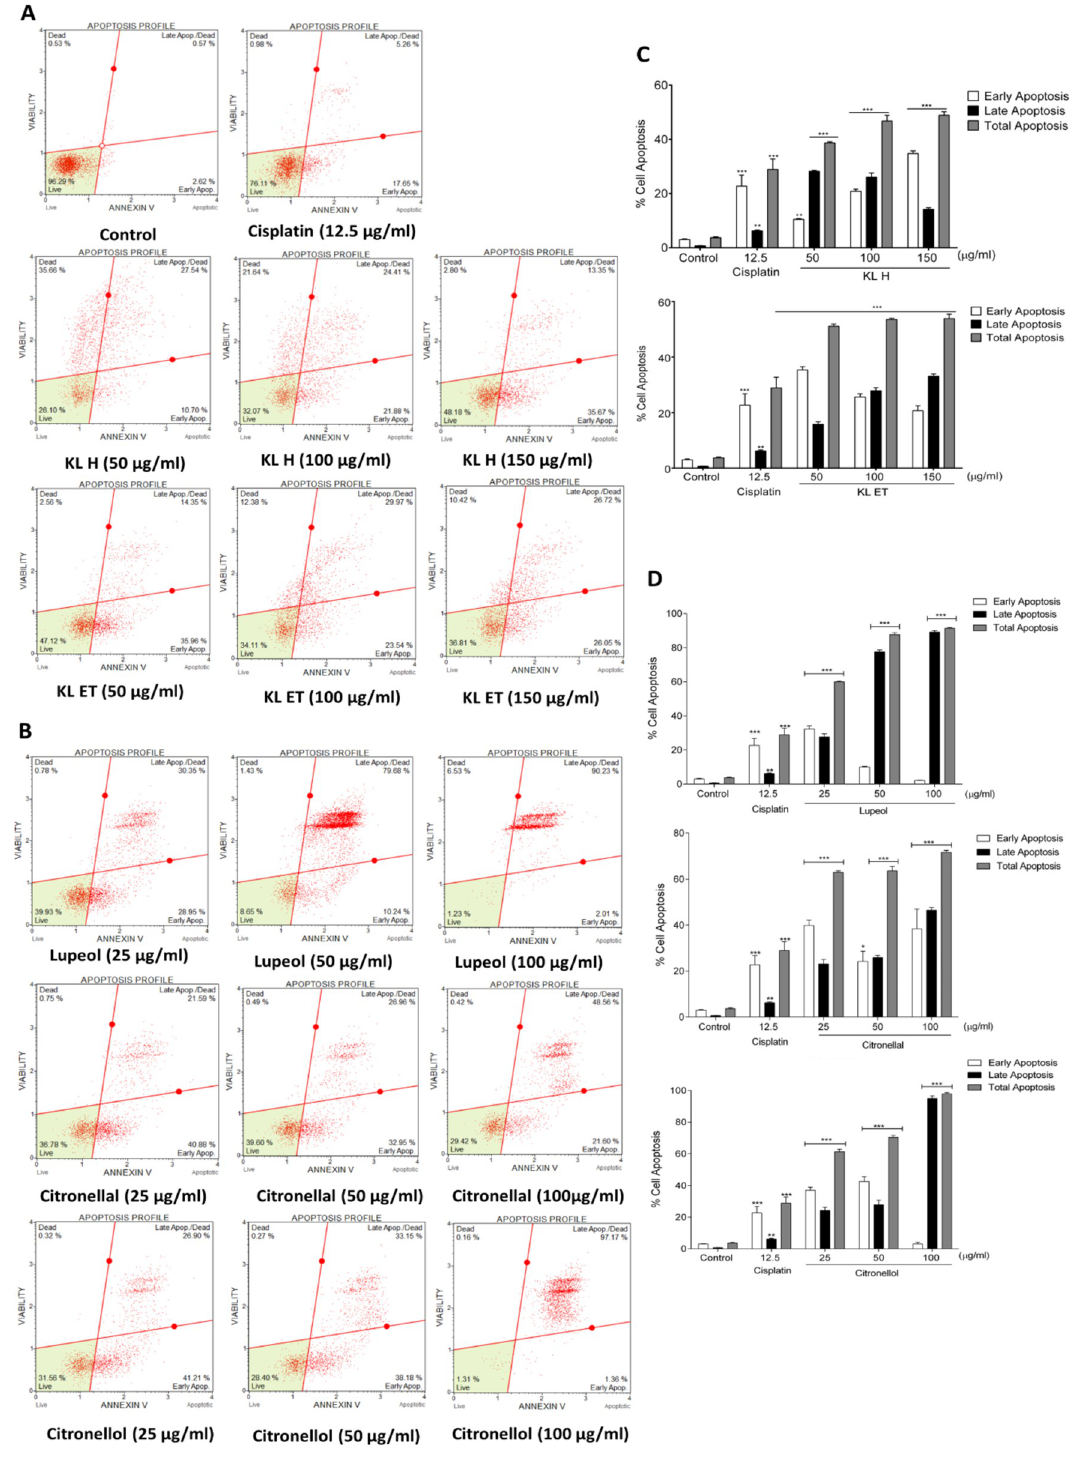
Fig 3. Determination of apoptosis in SCC15 cell line after treatment with KL H, KL ET, lupeol, citronellal and citronellol for 24 hours. (A) and (B) Dot plots of annexin V and 7-AAD dual staining showing the percentage of cell populations in each quadrant. (C) and (D) Bar graphs showing quantitative data of the percentage of early, late and total apoptotic cells. Results are presented as means ± SEM. �� Statistically significant ( p � 0.01) and ��� p � 0.001 compared to the control. KL H: Crude hexane; KL ET: Crude ethanolic